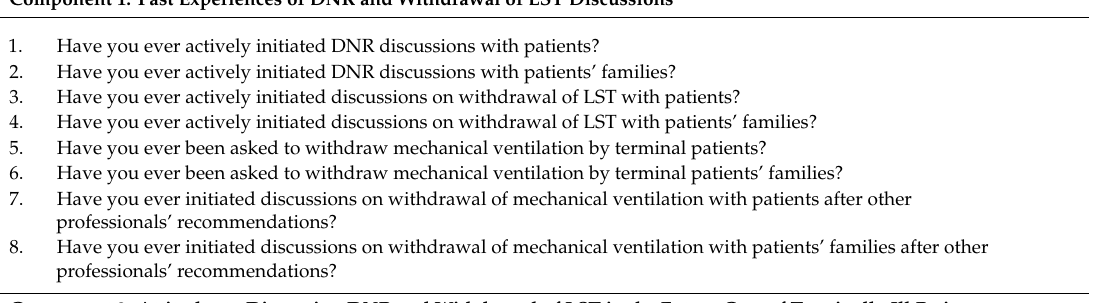
Table A1. Questionnaire Regarding Nurses’ Experiences and Attitudes toward Discussions